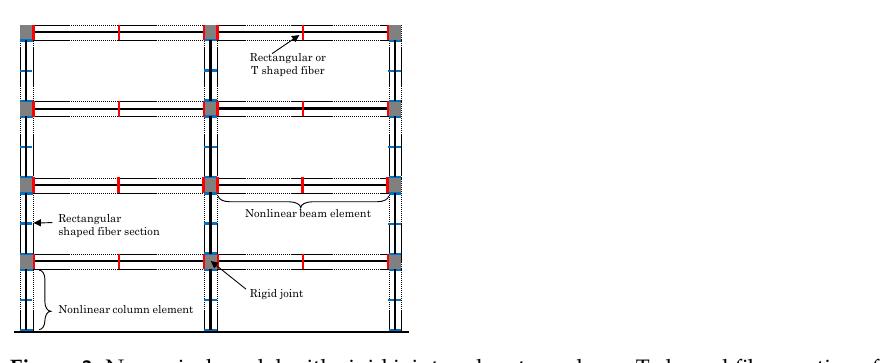
Figure 3. Numerical model with rigid joint and rectangular or T-shaped fiber sections for columns and beams. Table 7. Modeling material parameters for structural elements. (a) Concrete